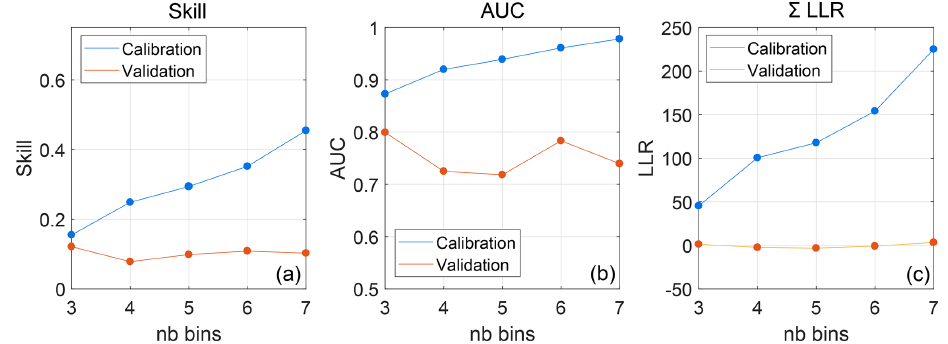
Figure 7. Performance metrics of shore-break BN as a function of the number of bins of the input variables and for validation and calibration: (a) skill sk, (b) area under ROC curve AUC and (c) the summed log likelihood ratio (cid:80) LLR.